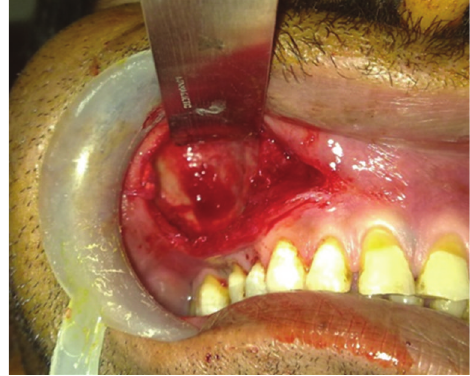
Figure 10: Surgical enucleation of the lesion through an intraoral approach, photograph after removal of the lesion in toto showing bony concavity on anterolateral wall of the sinus.